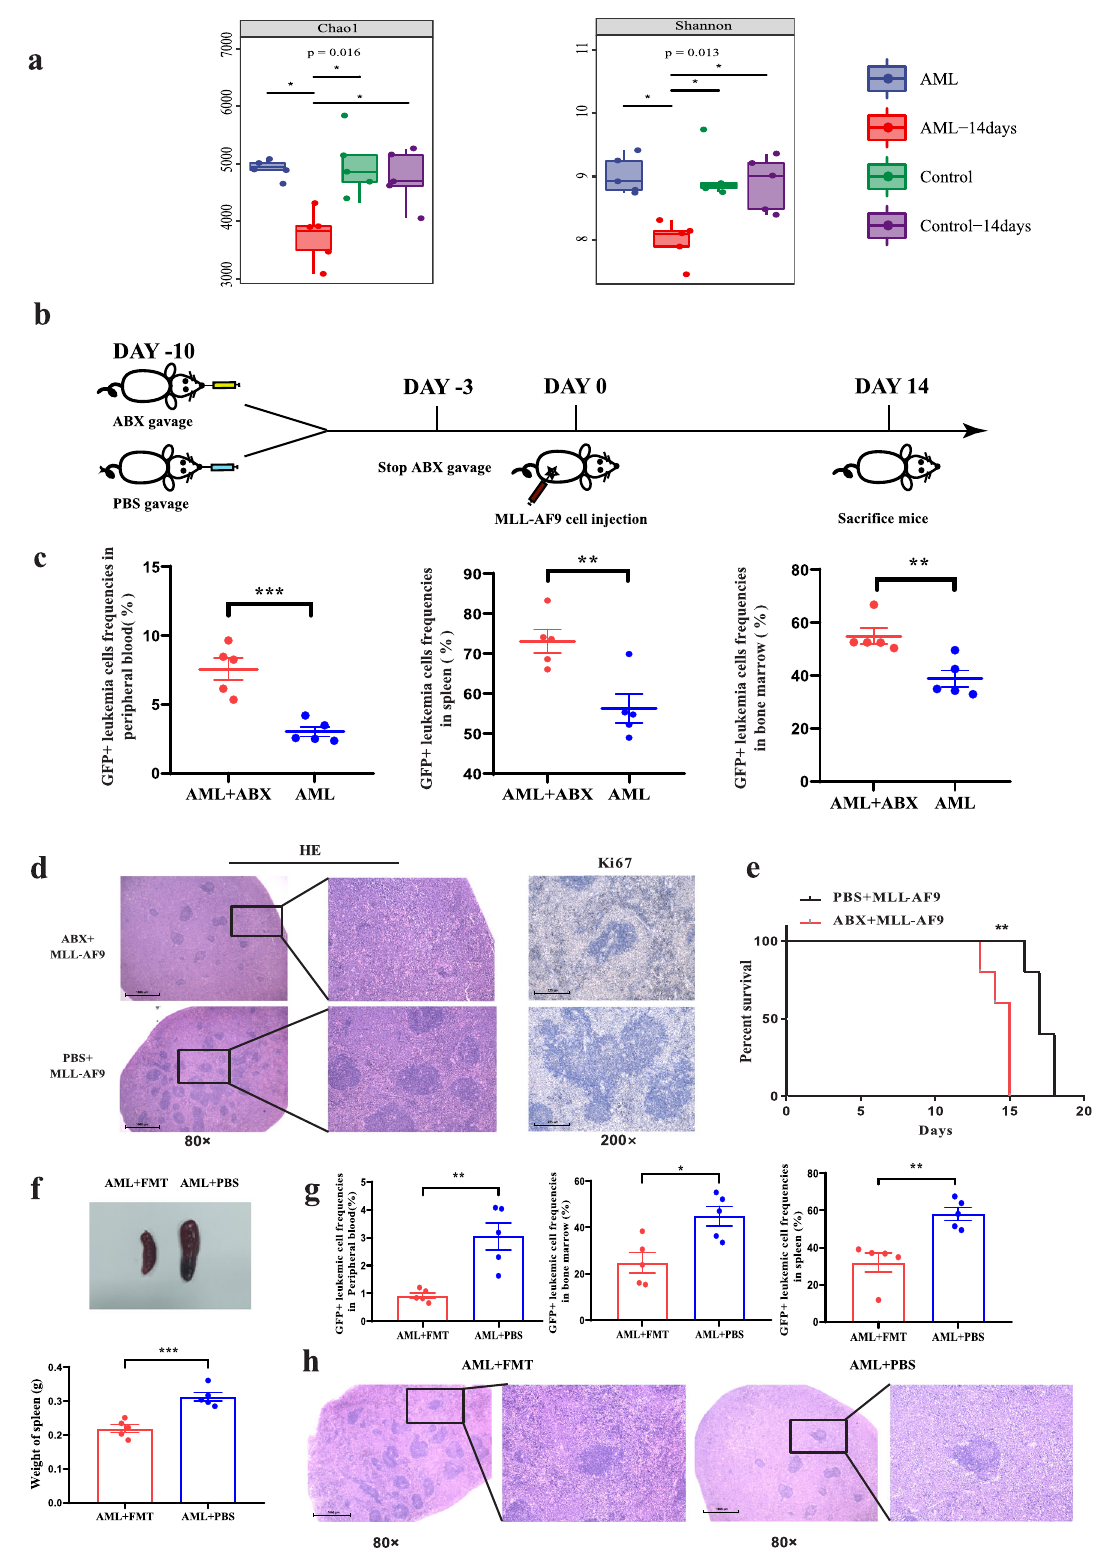
demonstrated that the leukaemia load in the spleen, BM, and peripheral blood of AML-FMT mice (antibiotic-treated AML mice followed by FMT with faecal hydration liquid from AML patients) increased signi fi cantly compared with that in the spleen, BM, and peripheral blood of Con-FMT mice (antibiotic-treated AML mice followed by FMT with faecal hydration liquid